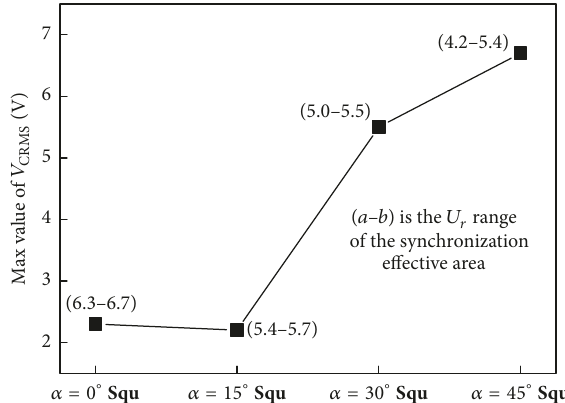
Figure 21: Comparison of maximum value of voltage output and synchronization effective area between VIVPEH with different shapes.